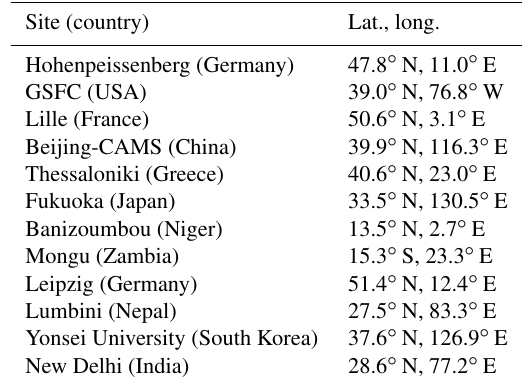
Table 1. AERONET sites used for the AOD validation analysis pre- sented in this study. Site